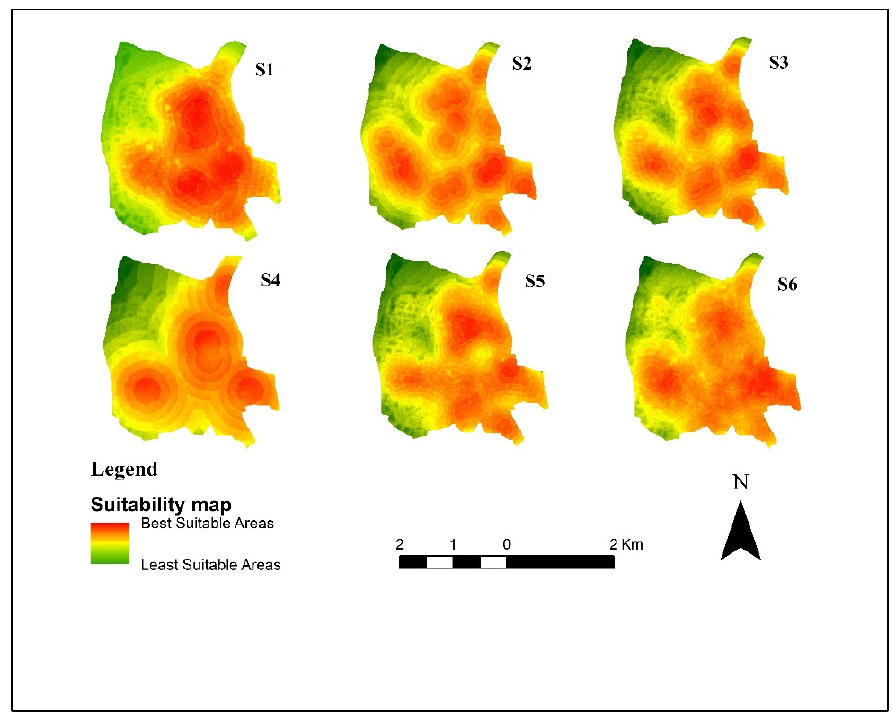
Figure 8. Sensitivity analysis of suitability map.